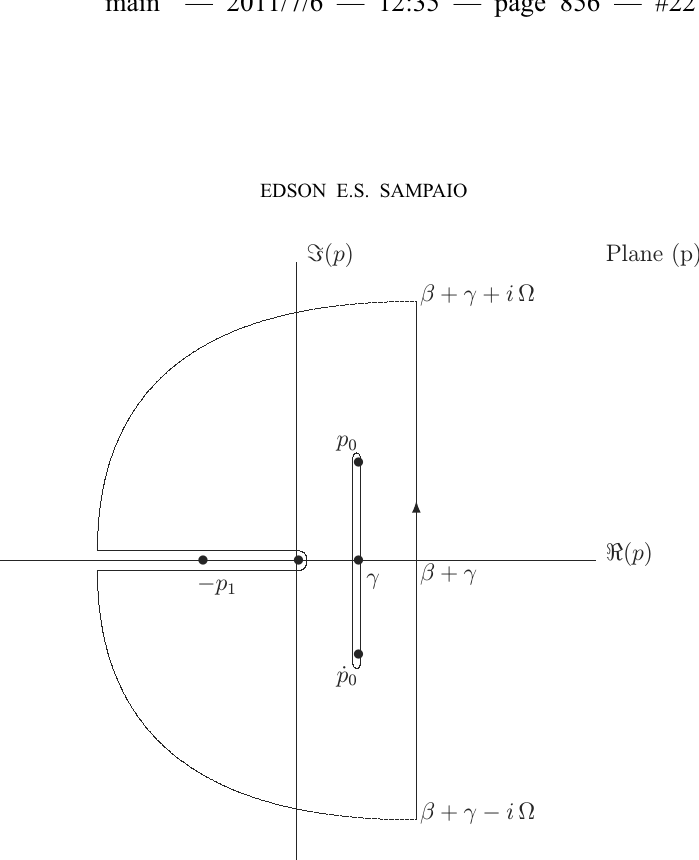
Fig. B1 – Distortion of the Bromwich path ( < ( p ) = β + γ ) into a closed contour for the integration of Equations B1, B2, and B4. The function is analytical inside the contour. The origin, − p 1 , p 0 , and ˙ p 0 are branch points, and γ is the